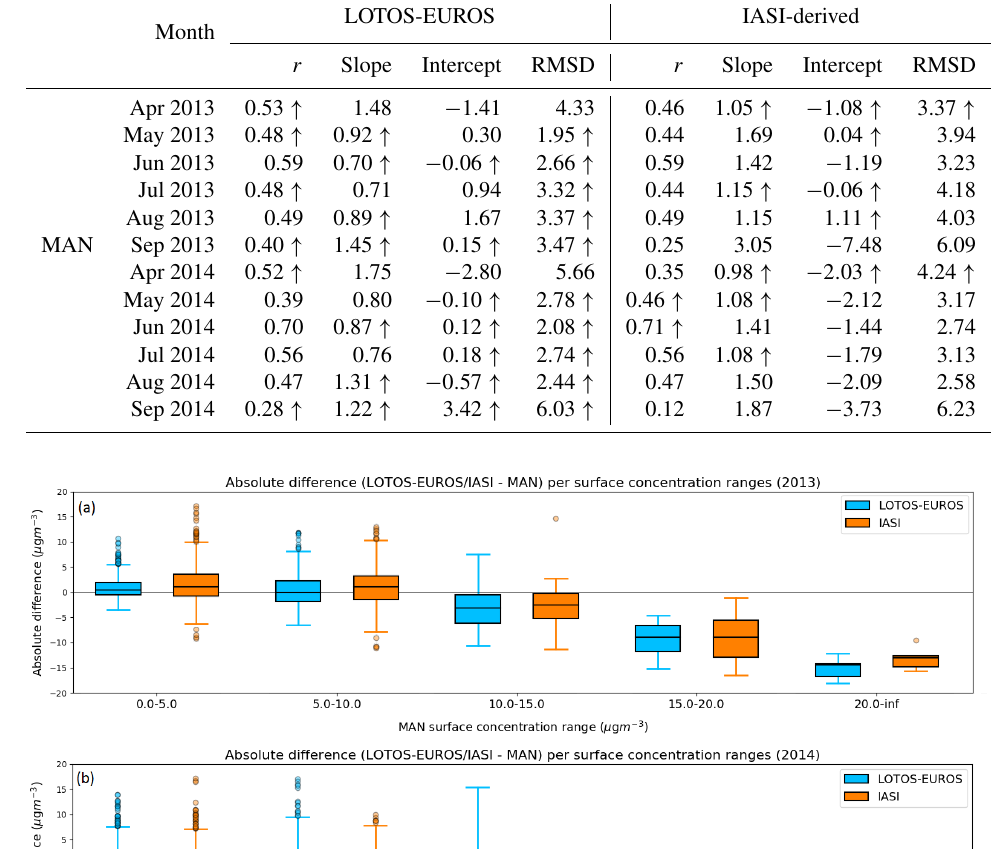
Table 4. Month-by-month comparison of the correlation coefficient ( r ), slope and intercept of the monthly mean NH 3 surface concentrations of the MAN stations ( x axis) and the coinciding monthly mean LOTOS-EUROS and IASI-derived NH 3 surface concentrations ( y axis). The arrows denote which of the two (LOTOS-EUROS or IASI) gives the most desirable values. The arrows are attributed to either LOTOS- EUROS or IASI based on the following criteria: highest r , slope closest to 1, intercept closest to 0 and smallest RMSD.